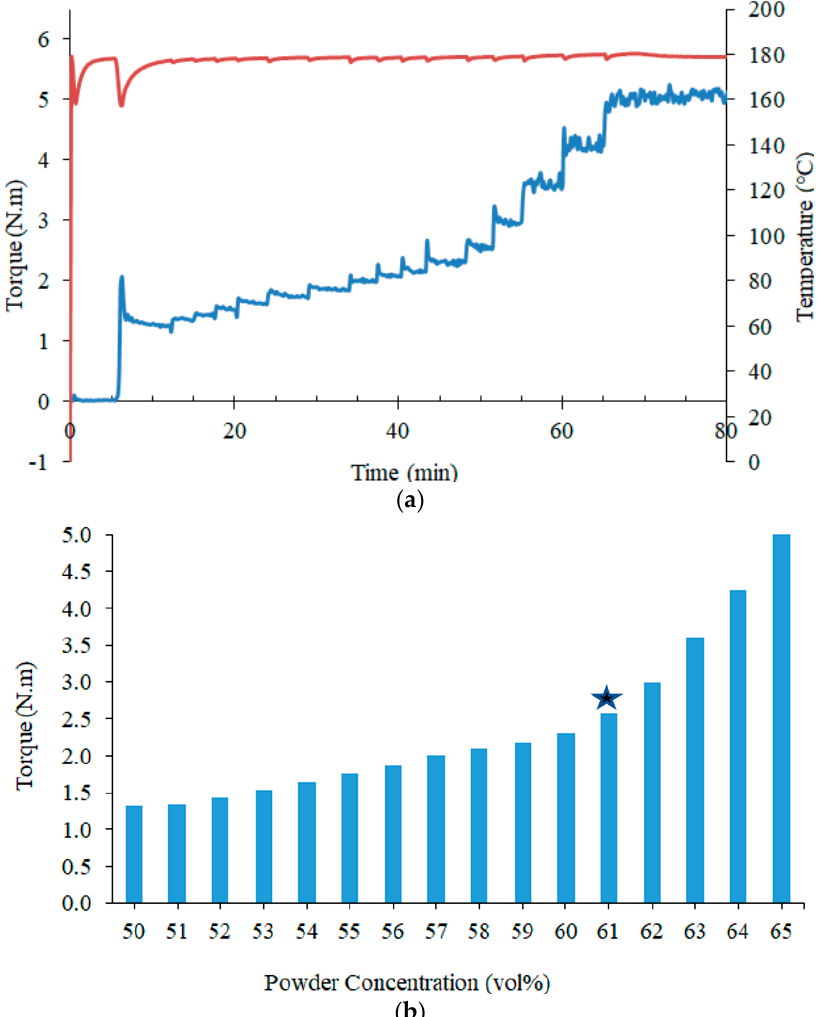
Figure 2. Feedstock optimization of SAE 316L stainless steel powder mixed with a commercialized binder system at 180 °C and 30 rpm: ( a ) torque evolution against time, the red curve represents temperature and the blue curve represents torque evolution and ( b ) torque versus powder concentration.